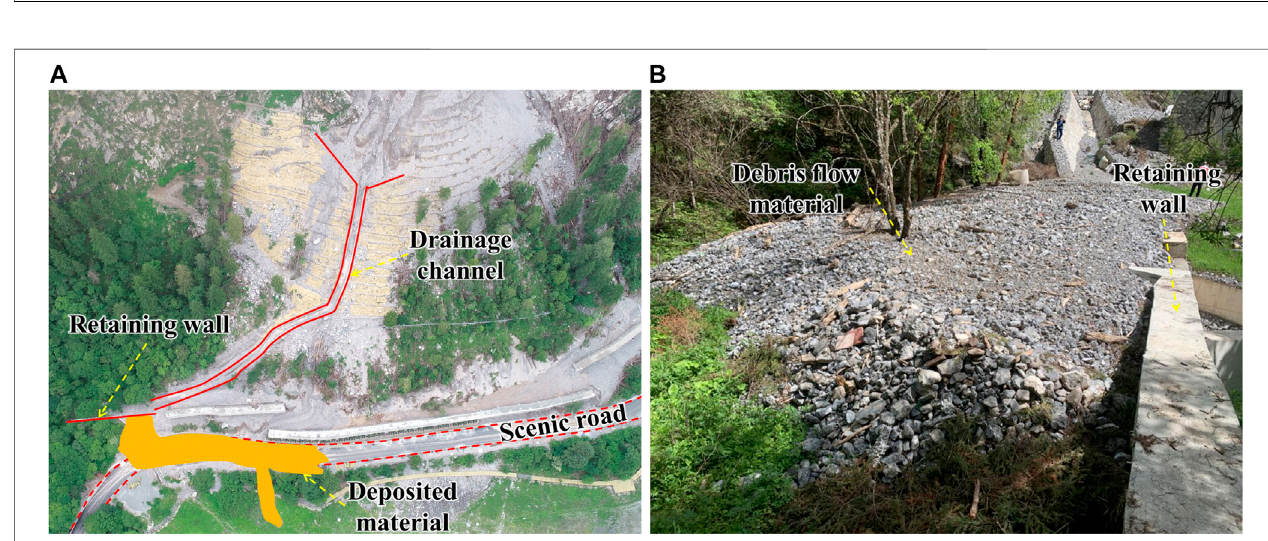
FIGURE 7 | Mitigation measures in Xuan Gully. (A) Overview of the mitigation structures. (B) The debris fl ow material transported on June 21, 2019.